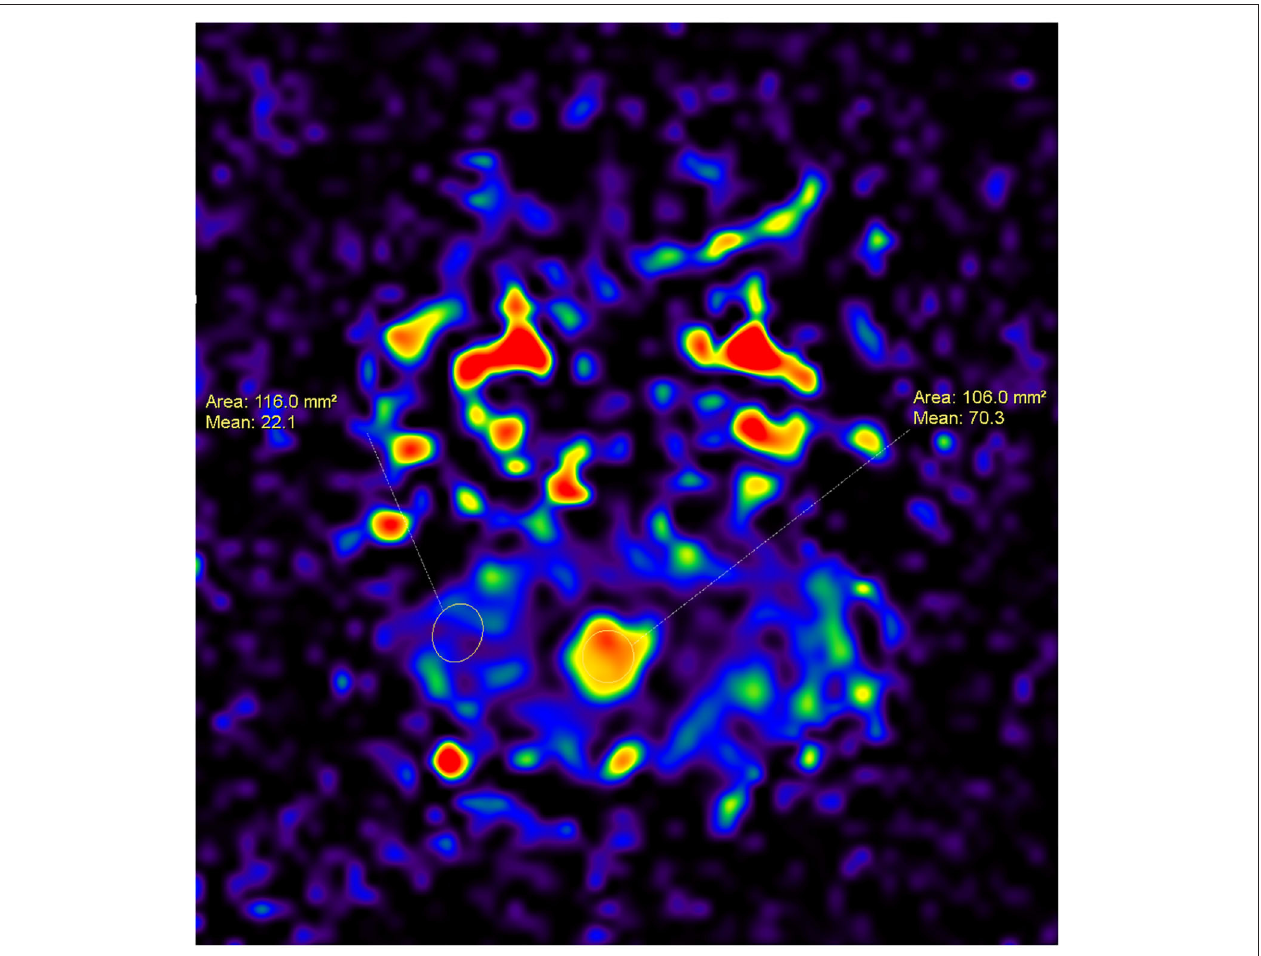
FIGURE 1 | A 7-year-old female patient with a tumor inside the fourth ventricle, which was confirmed as medulloblastoma after surgery. An ASL map was created by drawing ROIs within the area of the tumor and the area of the parenchyma. The CBF for the medulloblastoma is higher than that for the parenchyma (70.3 vs.